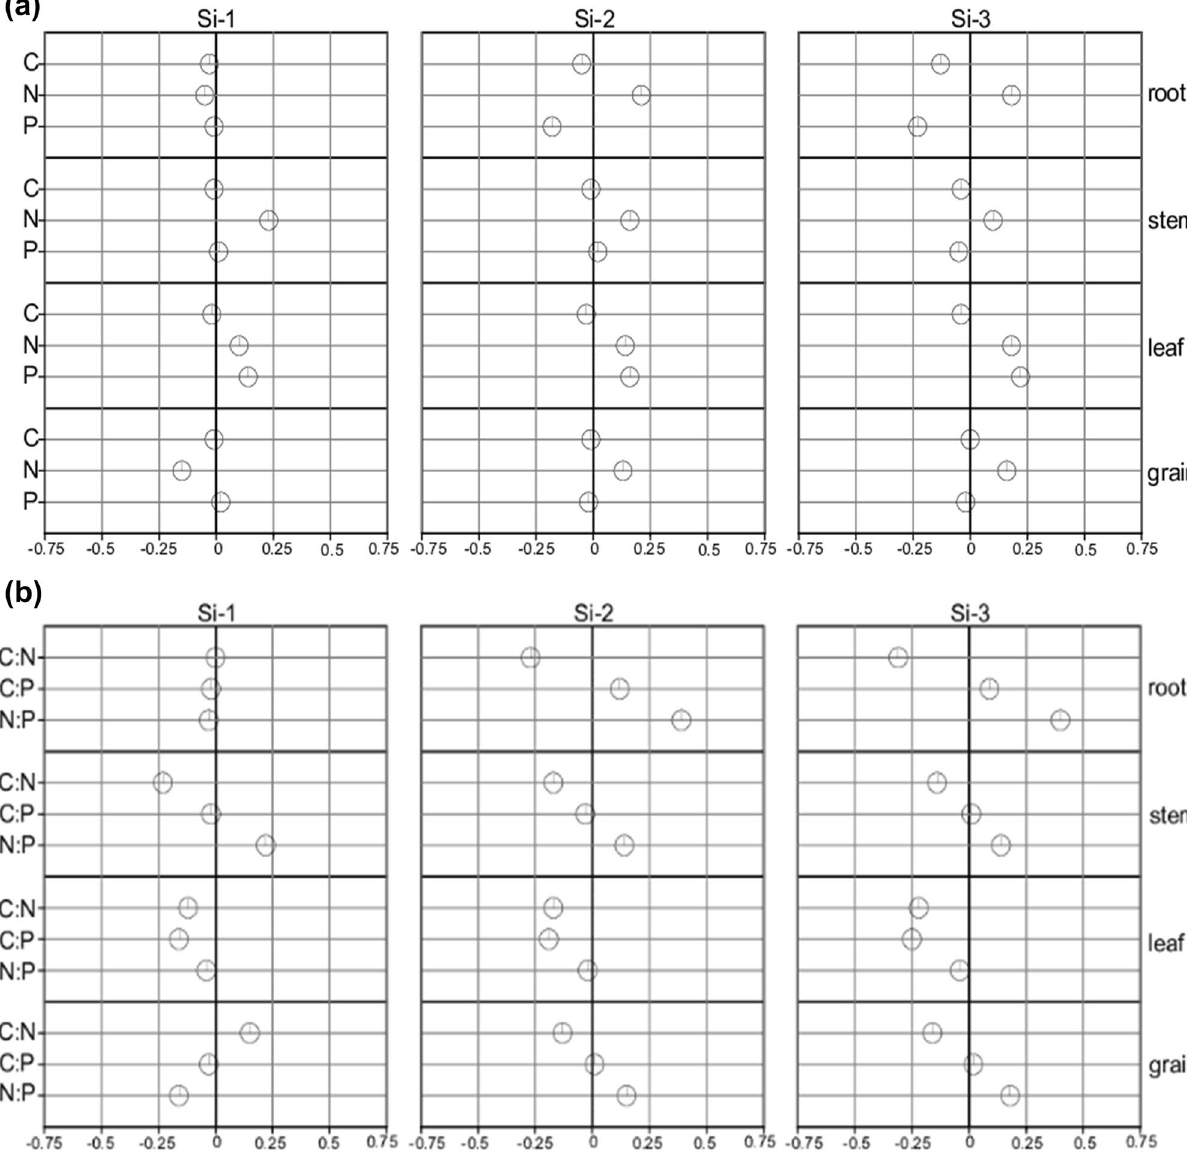
Figure 2. Changes [ln (x-Si-L/x-Si-0) ± ln (SD-Si-L/SD-Si-0), where x is the variable mean value and L is the Si addition level; n = 5] in carbon, nitrogen and phosphorus levels ( a ) and; C:N, C:P and N:P stoichiometric ratios ( b ) of analyzed organs for the studied Si